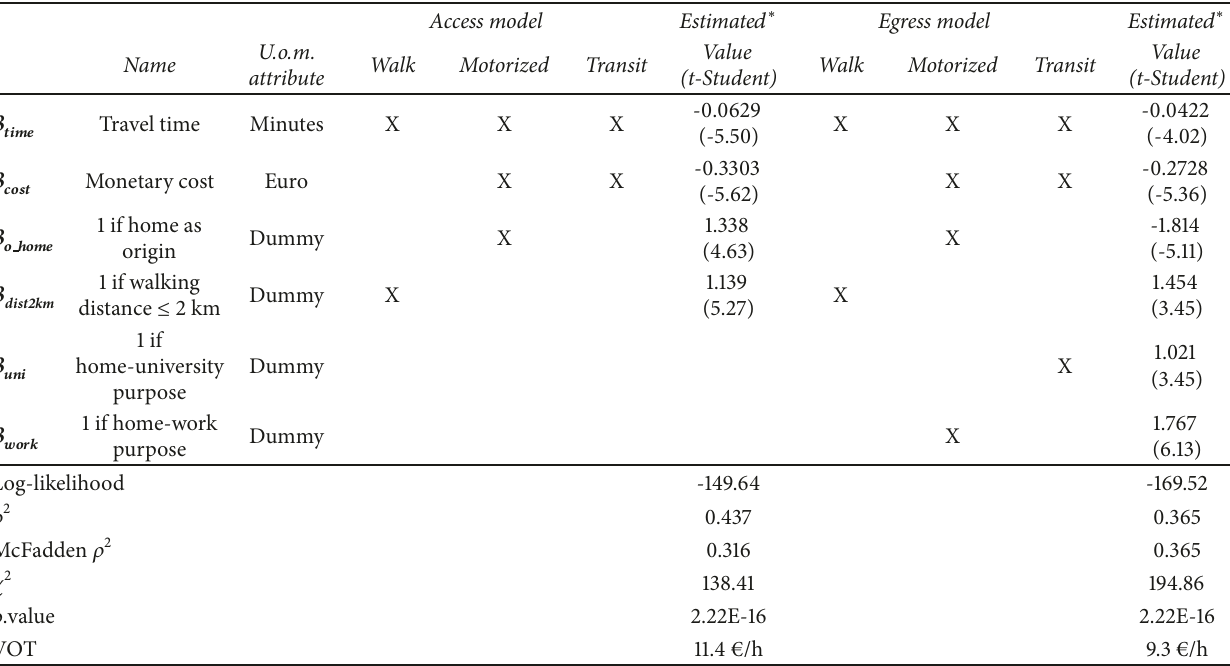
Table 1: Calibrated RP